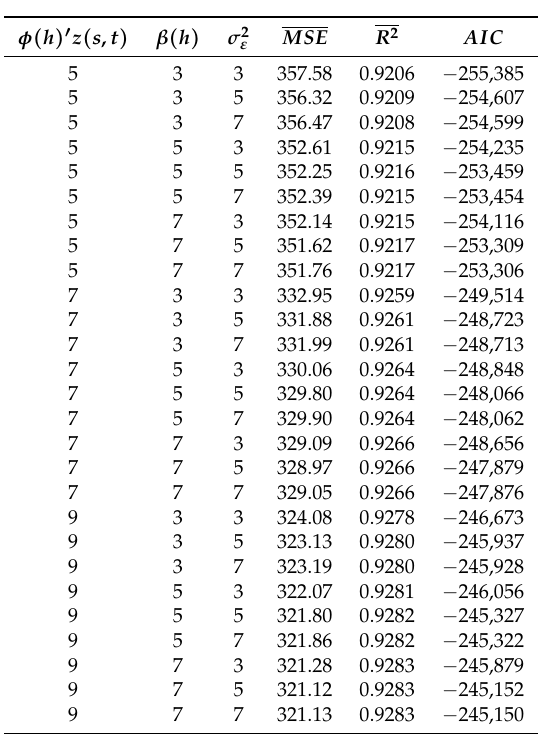
Table 2. Criteria MSE , R 2 , and AIC under different numbers of Fourier